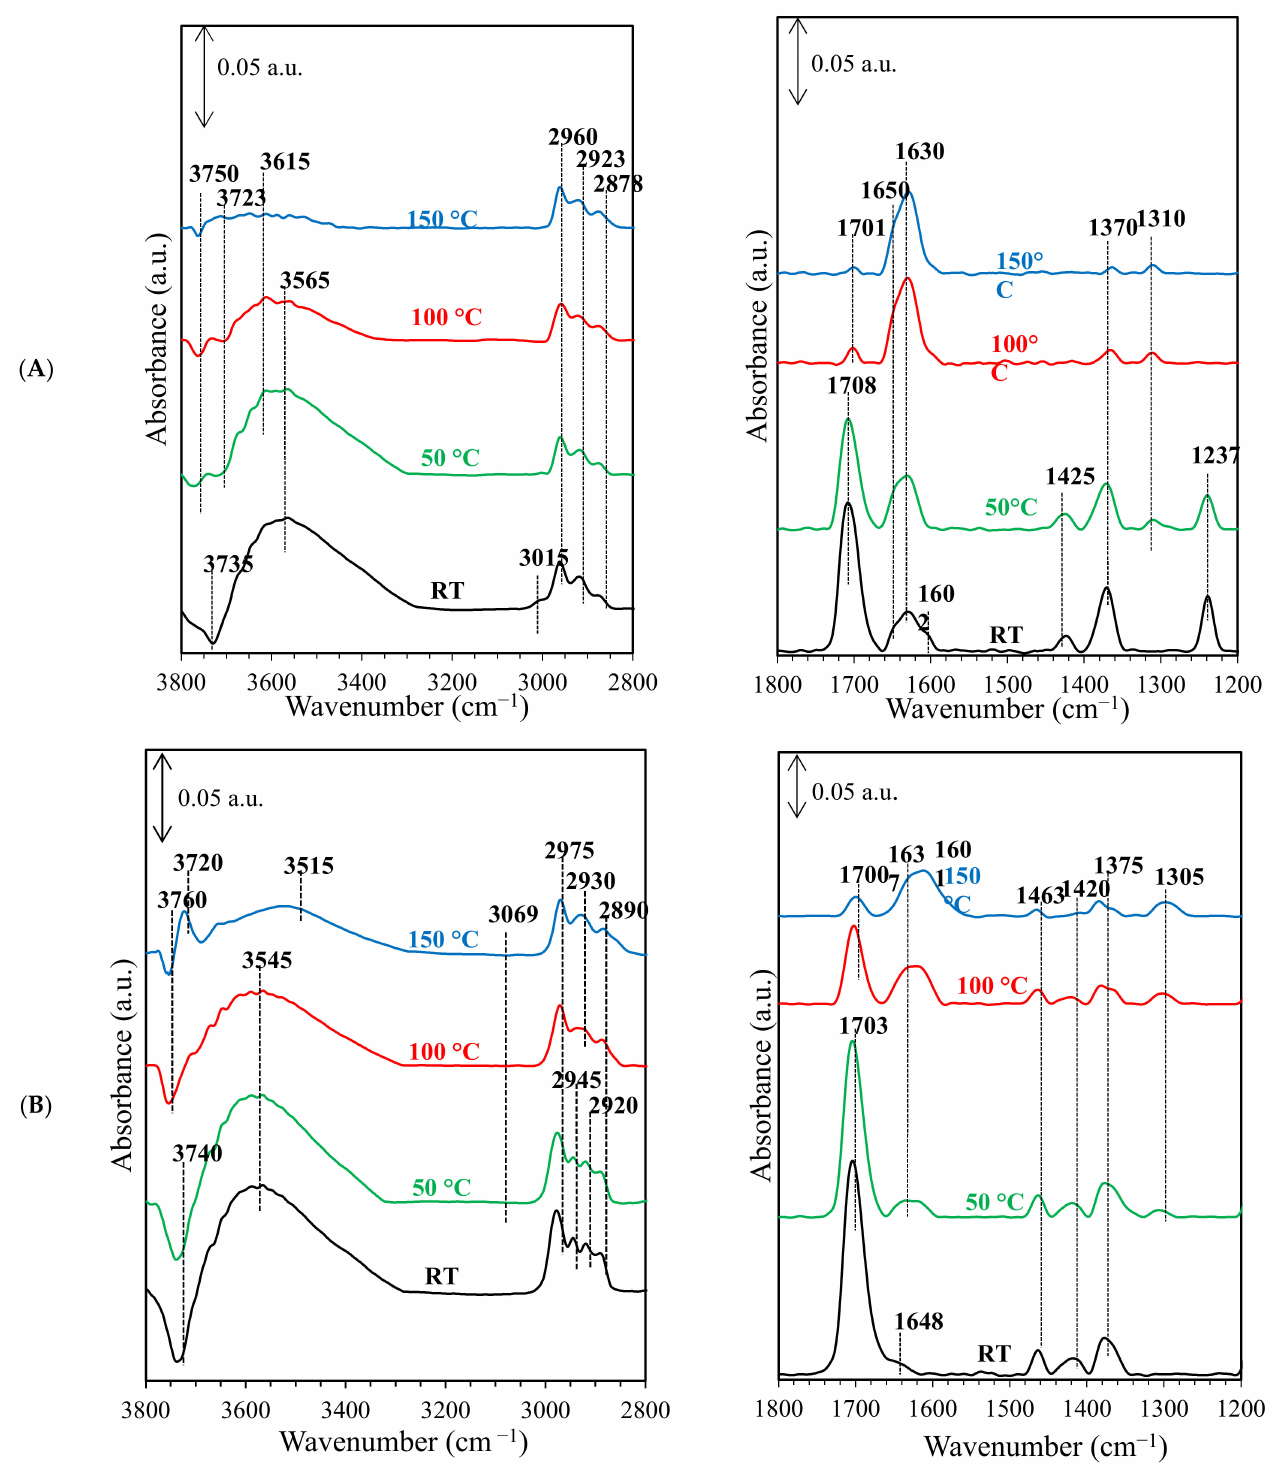
Figure 9. In situ FITR spectra of a representative MgAl mixed oxide after the adsorption of ( A ) acetone and ( B ) 2-butanone at room temperature, followed by activation at different temperatures. At room temperature, the bands at 1650, 1630, and 1310 cm − 1 were ascribed to the stretching mode of OCO in the adsorbed carbonate species derived from the acetone [42], as is illustrated in Figure S3 (SI). Similarly, the carbonate species of 2-butanone was detected per the bands at 1648, 1637, and 1305 cm − 1 . The enol-like intermediates that